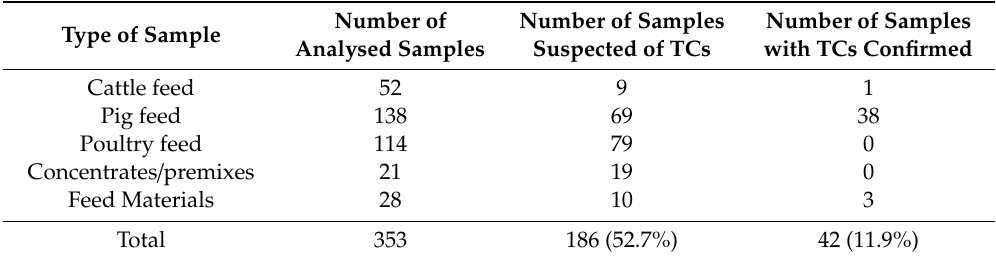
Table 1. The number of samples contaminated with tetracyclines (TCs).